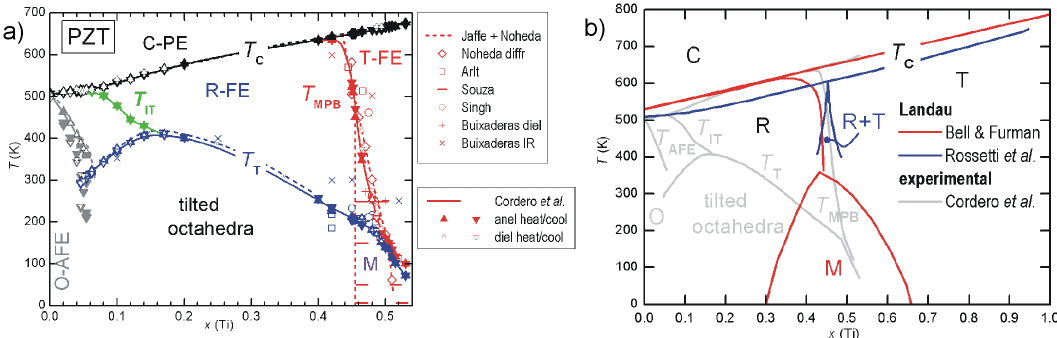
Figure 5. ( a ) phase diagram of PZT deduced from several experimental techniques. Thick lines and triangles: anelastic and dielectric, Cordero et al. [76–80]; dashed lines: standard phase diagram of Jaffe et al. [4] with revision of Noheda [8]; additional MPB points from dielectric, Arlt [81]; Raman, Souza et al. [82]; XRD, Singh et al. [83]; IR reflectivity, Buixaderas et al. [84] ( b ) two examples of phase diagrams obtained with the Landau theory truncated to the 6th order and (i) using a double order parameter in order to obtain an intermediate M phase (Bell & Furman [74]); (ii) only coexistence of R and T phase (Rossetti et al. [85]); the grey lines are from the experimental phase diagram on the